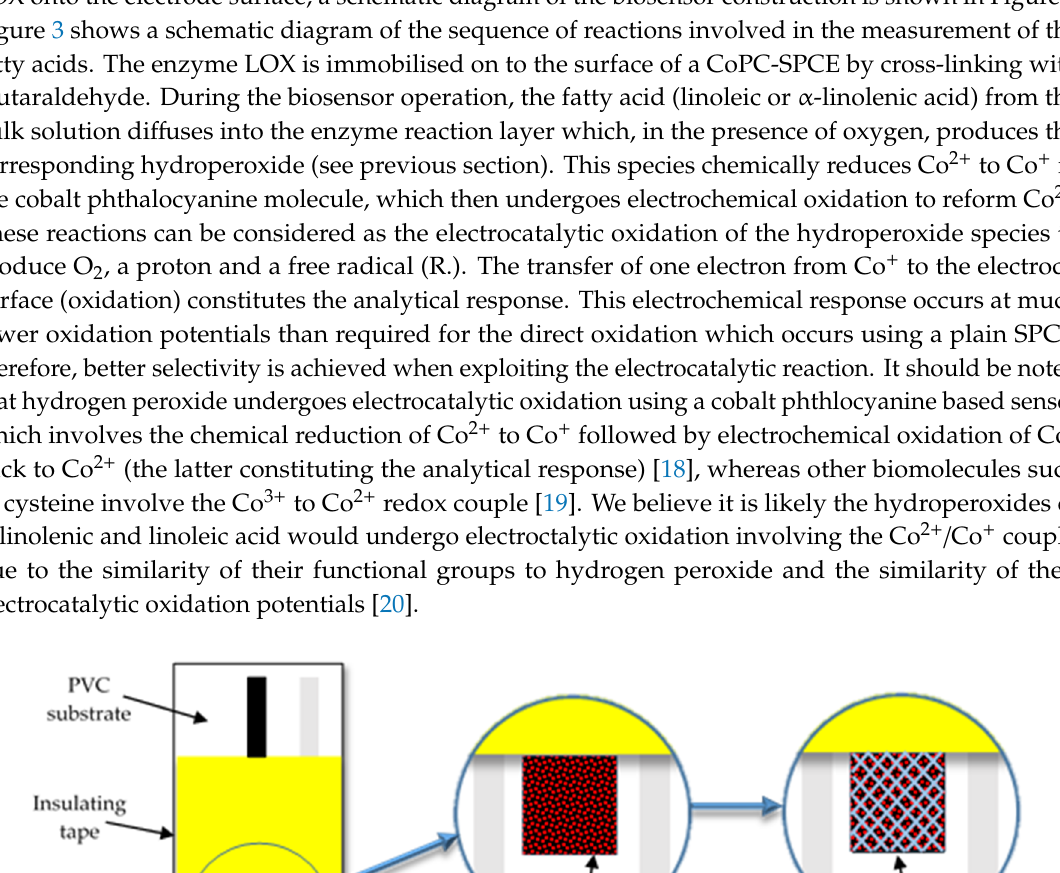
Figure 3. Schematic diagram of the amperometric fatty acid biosensor design and the sequence of reactions involved in its operation; SPCE = screen-printed carbon electrode; LOX = lipoxygenase; GLA = glutaraldehyde. In order to deduce the surface morphology of the biosensor during the modification processes, we employed scanning electron microscopy. Figure 4 shows a series of three SEM images obtained during the construction of the amperometric biosensor: image (i) shows the initial CoPC-SPCE, as can be seen characteristic flakes of carbon are evident, and it is clear that the CoPC-SPCE has a porous, three dimensional structure; image (ii) was taken after the deposition of LOX, followed by a drying step; the enzyme layer is dispersed evenly in discrete structures; image (iii) was obtained after the deposition of a glutaraldehyde layer on top of the enzyme layer, followed by a drying/cross linking step. This latter step results in a cohesive coating that was considered to strongly immobilise the enzyme onto the SPCE-CoPC surface. At the stage, we considered that the biosensor should be suitable for our proposed method of operation, for fatty acid analysis, involving amperometry in stirred solution. This is discussed in the following section.